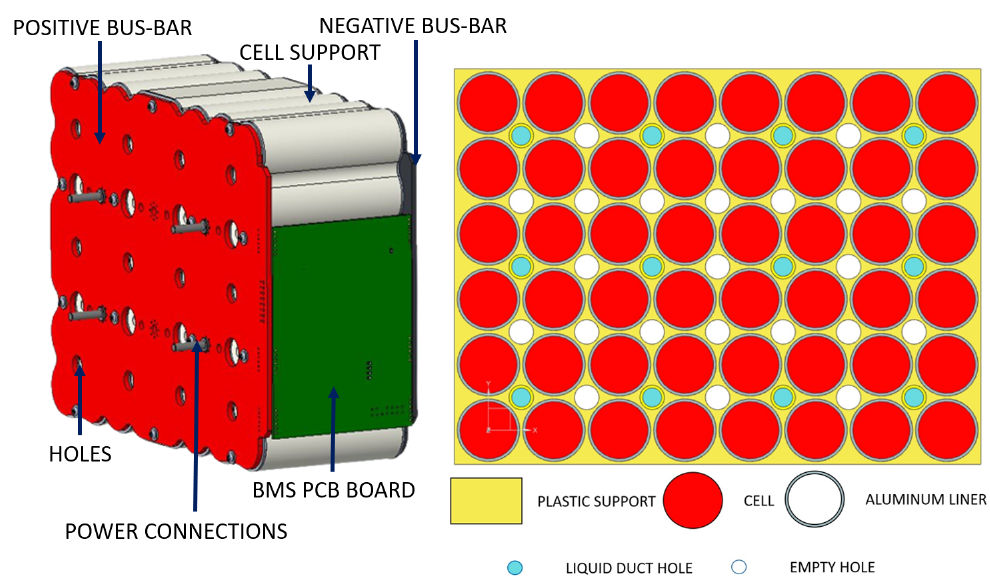
Figure 2. A scheme of the LiBER brick ( left ) and a section of the LiBER brick plastic support ( right